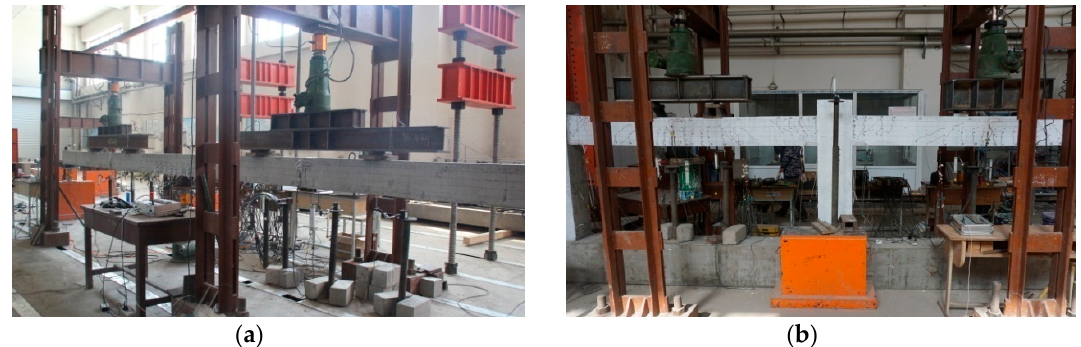
Figure 3. Photographs of the test setups: ( a ) continuous beams; and ( b ) continuous frames.